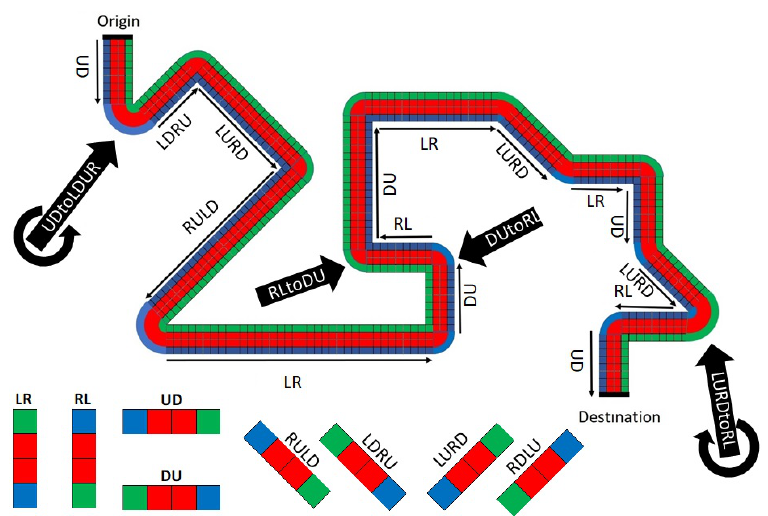
Figure 3. An example of a 3-mode 4-cell width corridor and its eight moving neighborhoods where each mode is in a different color.